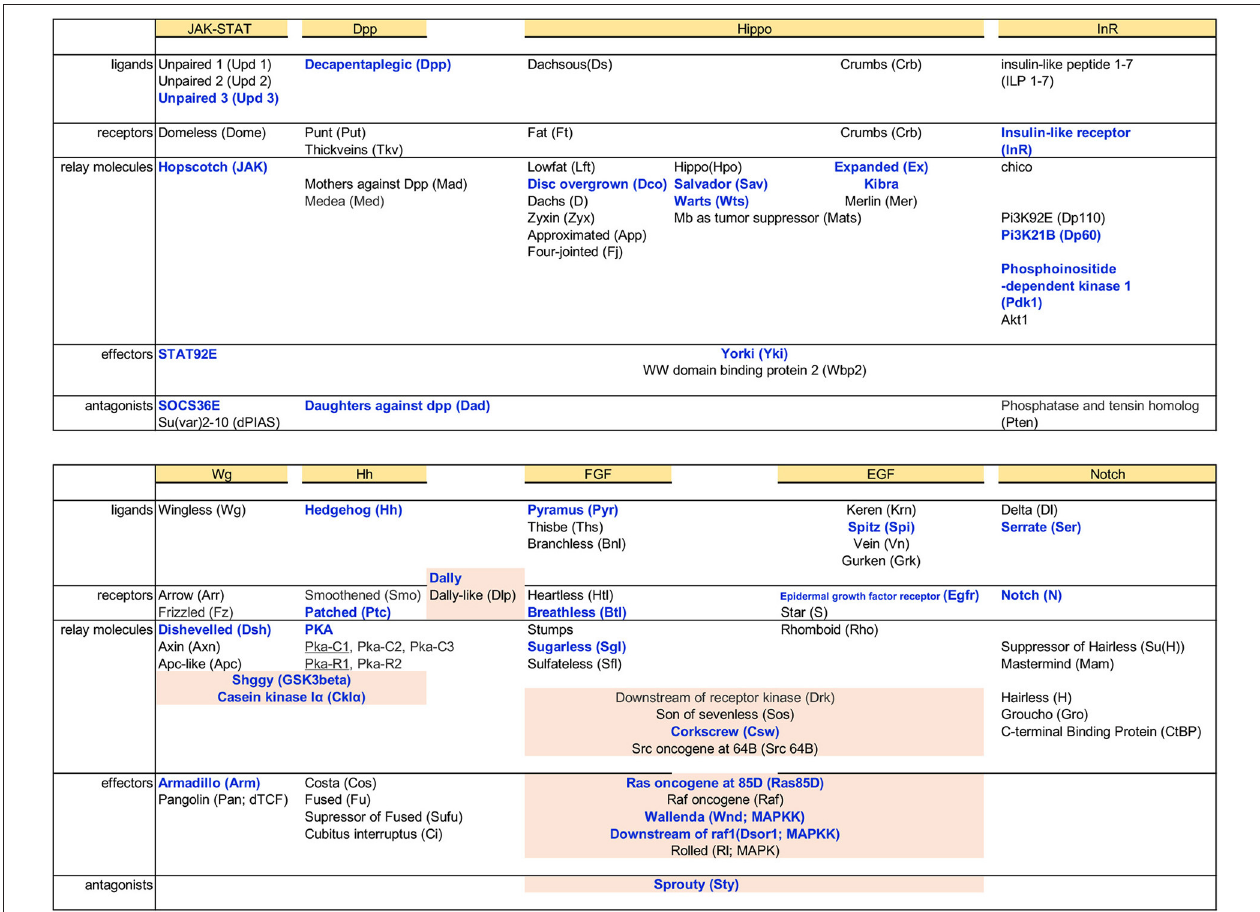
FIGURE 5 | Dam-Pol II binding to components of signaling pathways. Basic components of each signaling pathway, from the top ligands, receptors, signal relay molecules, effectors, and antagonists, are listed. Genes bound by Dam-Pol II are shown in bold blue. Components shared between pathways are highlighted in light